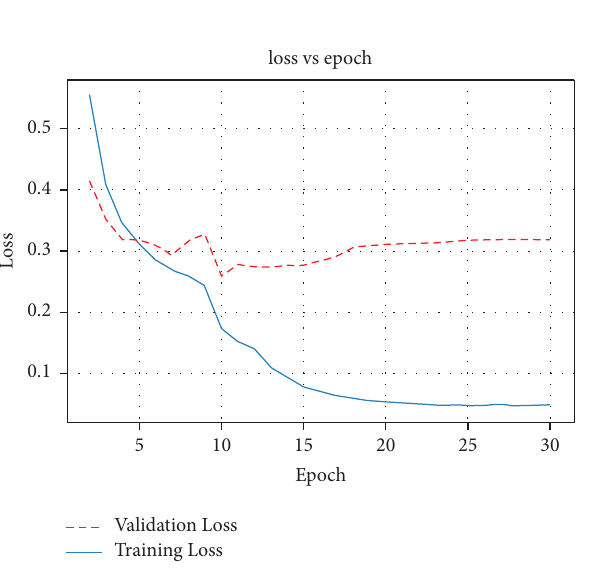
Figure 12: Observed loss for case 1.